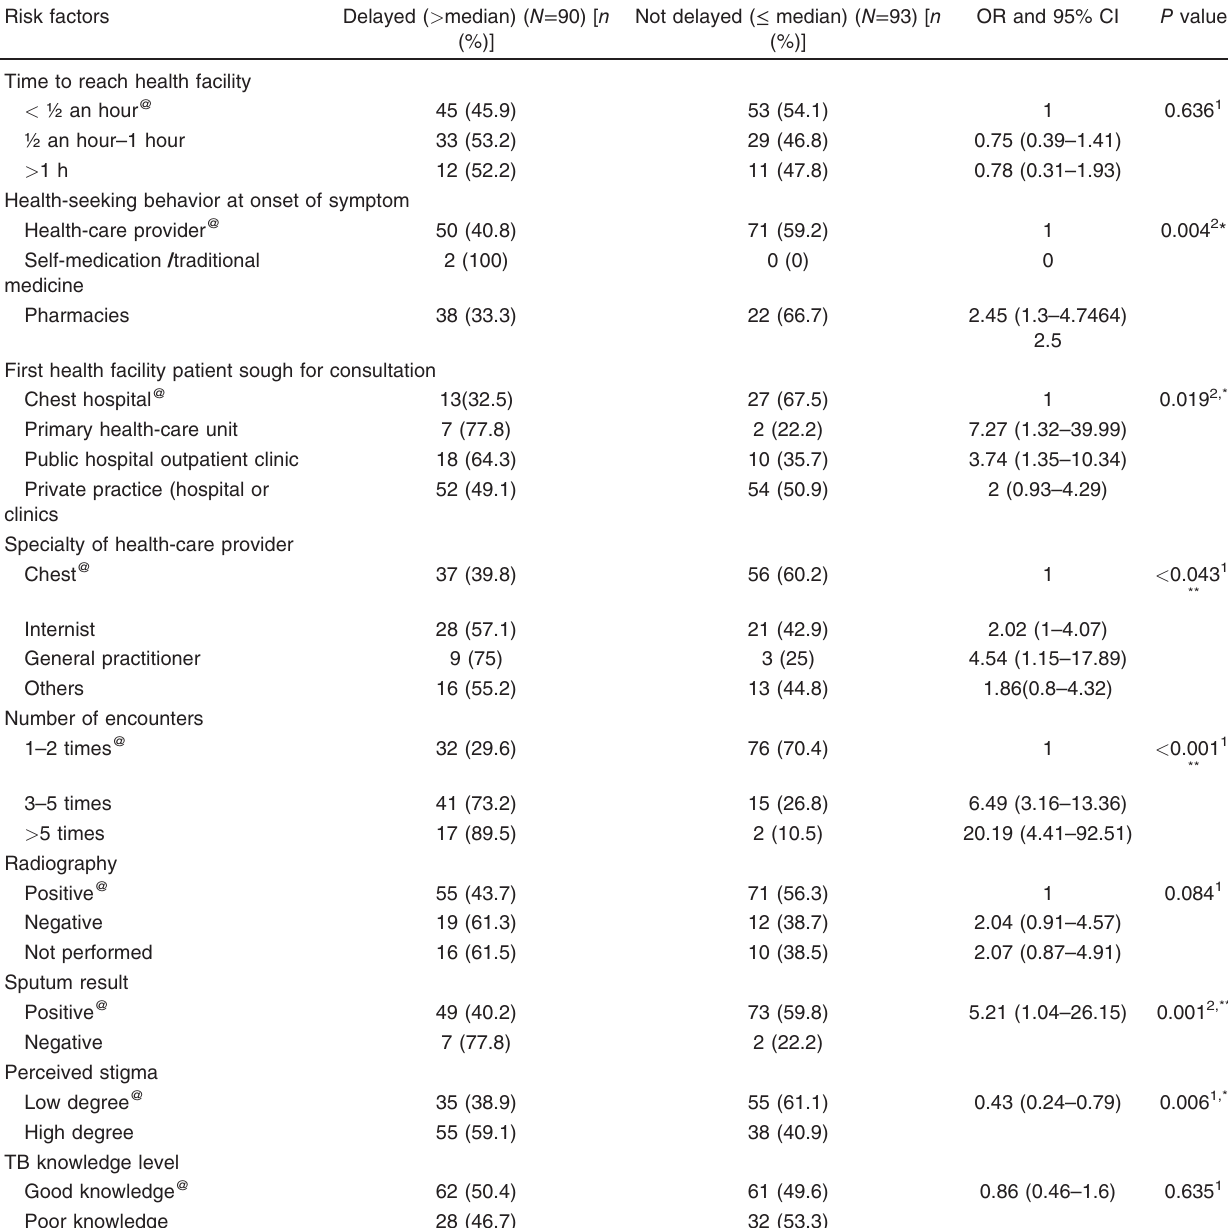
Table 5 Risk factors for total delay among studied patients ( N = 183) Risk